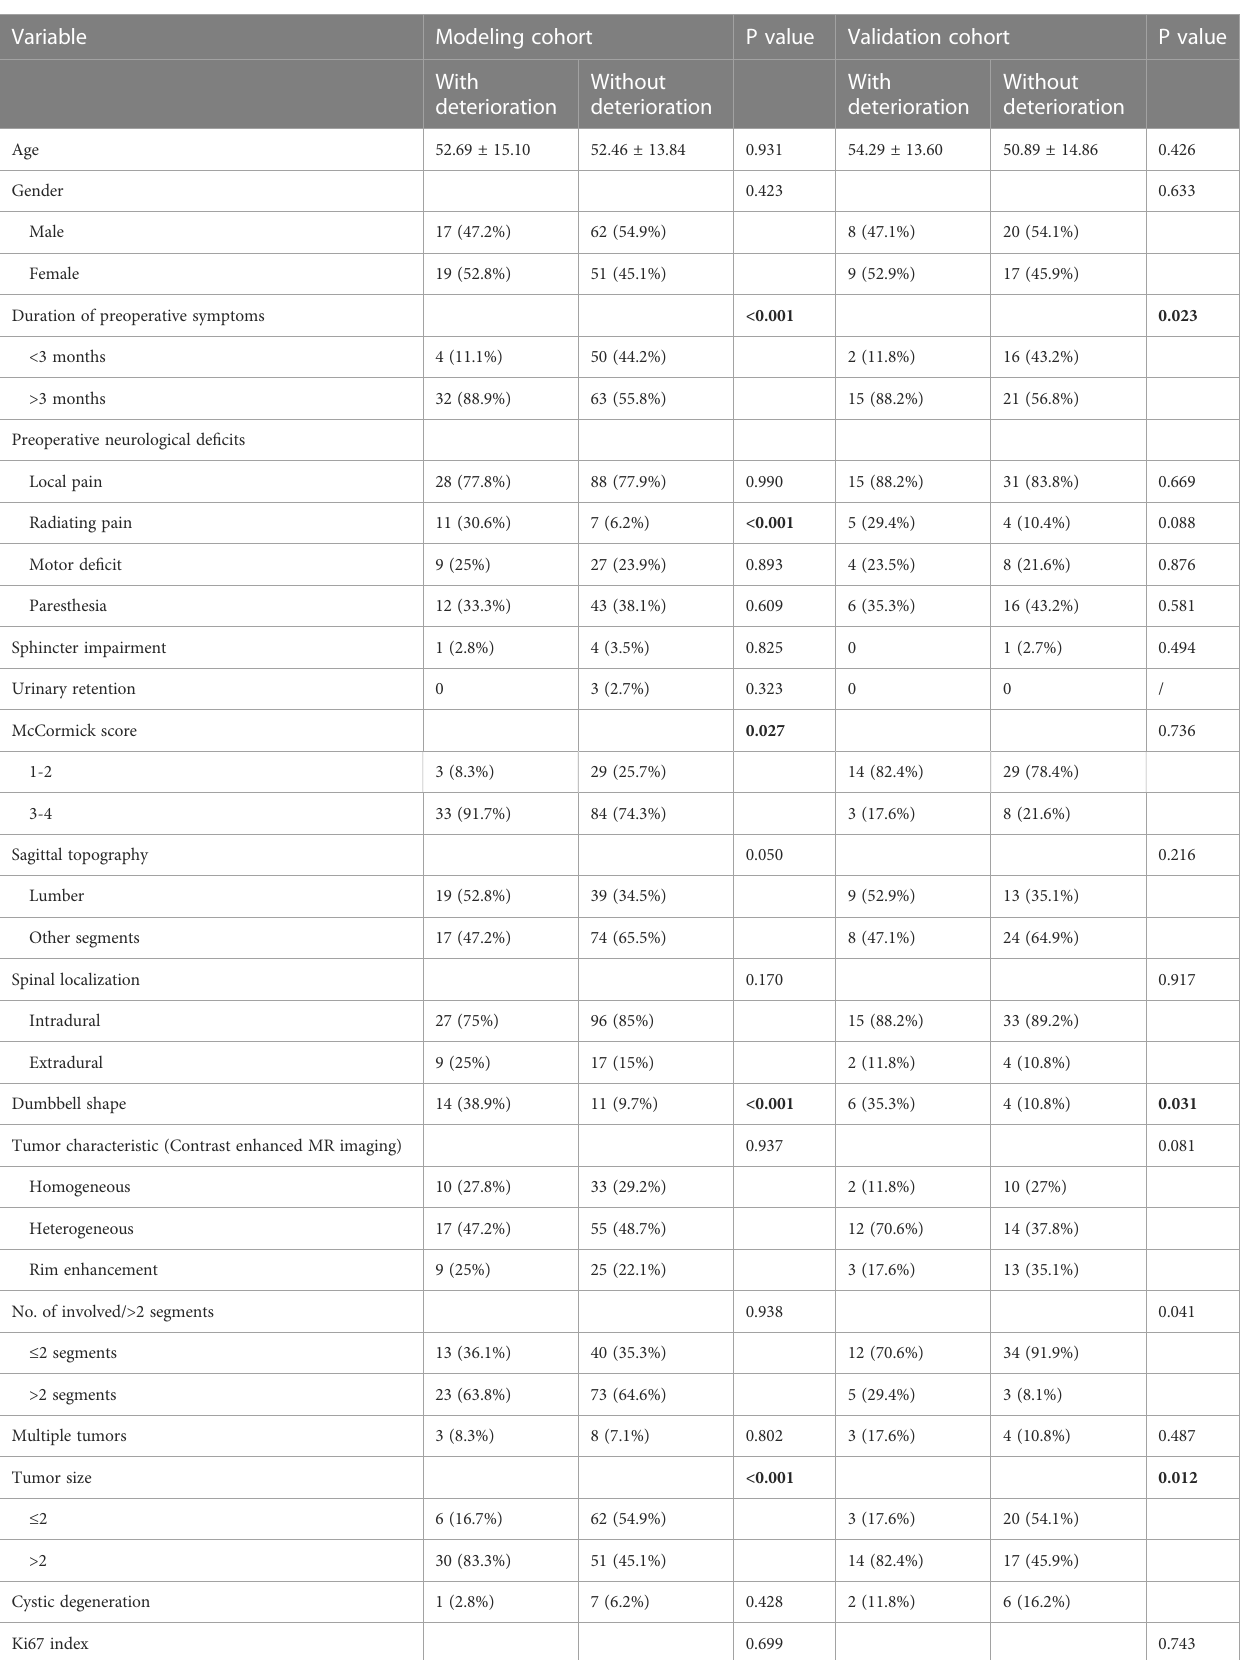
TABLE 3 Demographic and baseline characteristics of the study population and univariate analysis results of modeling cohorts and validation